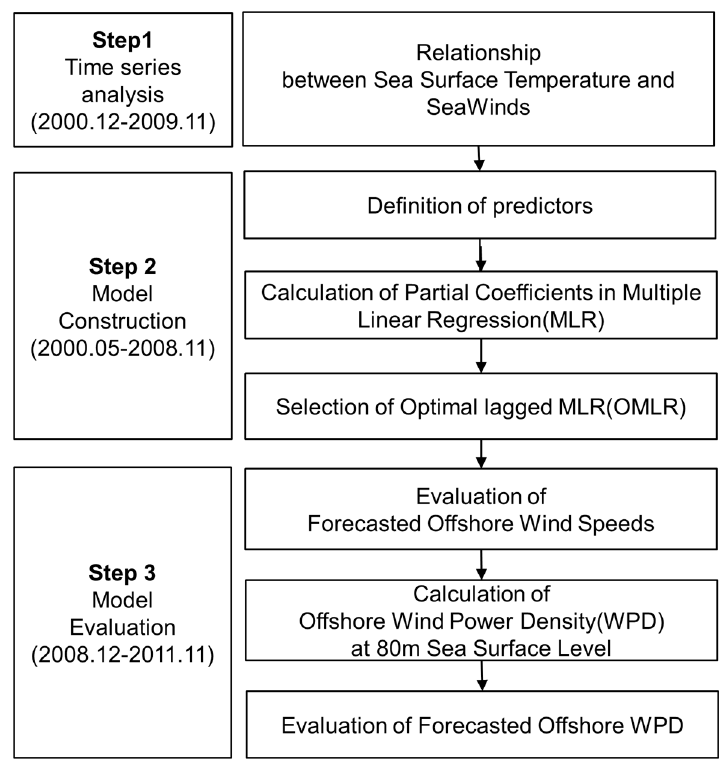
Figure 2. Schematic diagram of the wind speed forecasting model based on the multiple linear regression method.